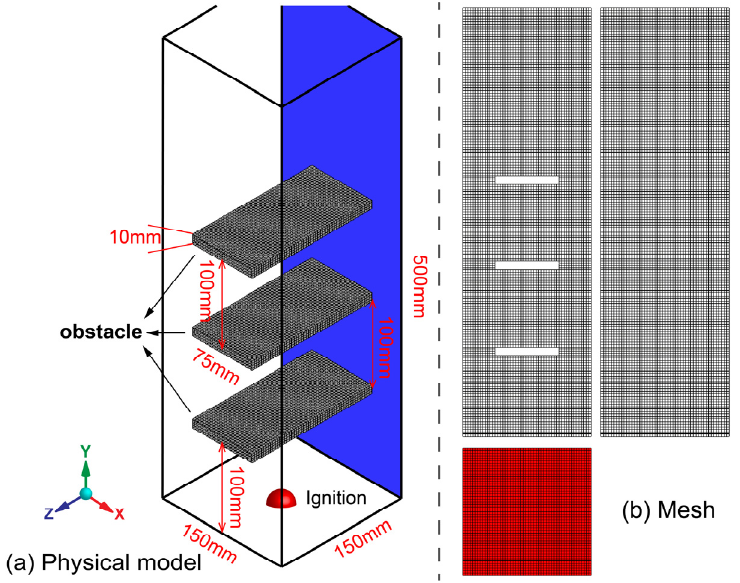
Figure 1. Physical model and mesh model of the experiment.